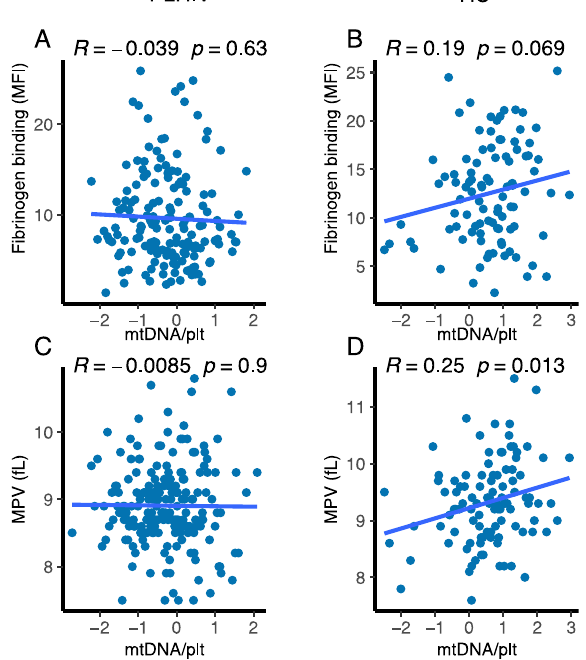
Figure 5. Association of platelet mitochondrial DNA with platelet reactivity and mean platelet volume (MPV). ( A , B ) correlation of normalized mitochondrial DNA content in platelets (mtDNA pl ) and the binding of fibrinogen to the activated integrin αIIbβ3 after ex vivo platelet stimulation with ADP (125uM) in PLHIV ( A ) and healthy controls ( B ). ( C , D ) correlation of normalized mitochondrial DNA content in platelets (mtDNA pl ) and MPV in PLHIV ( C ) and healthy controls ( D ). All correlations were analyzed using Pearson’s correlation